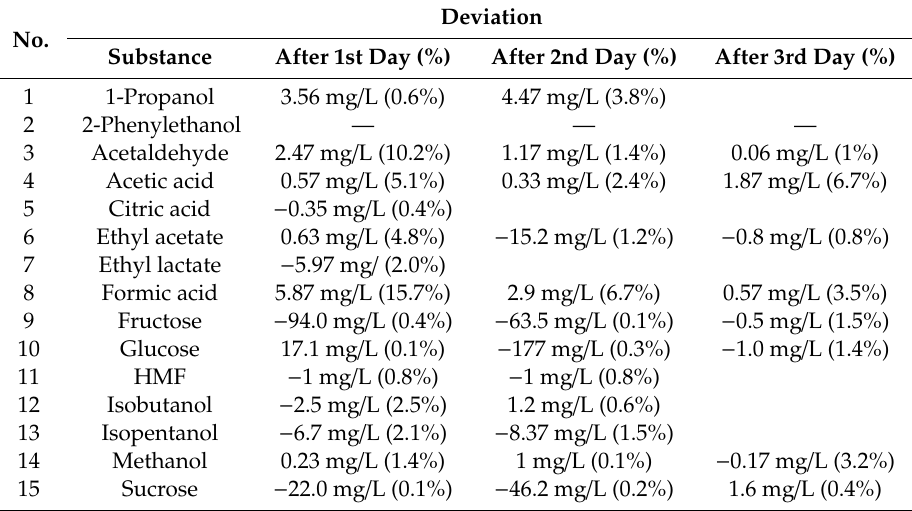
Table 6. Stability of individual ingredients in spirit